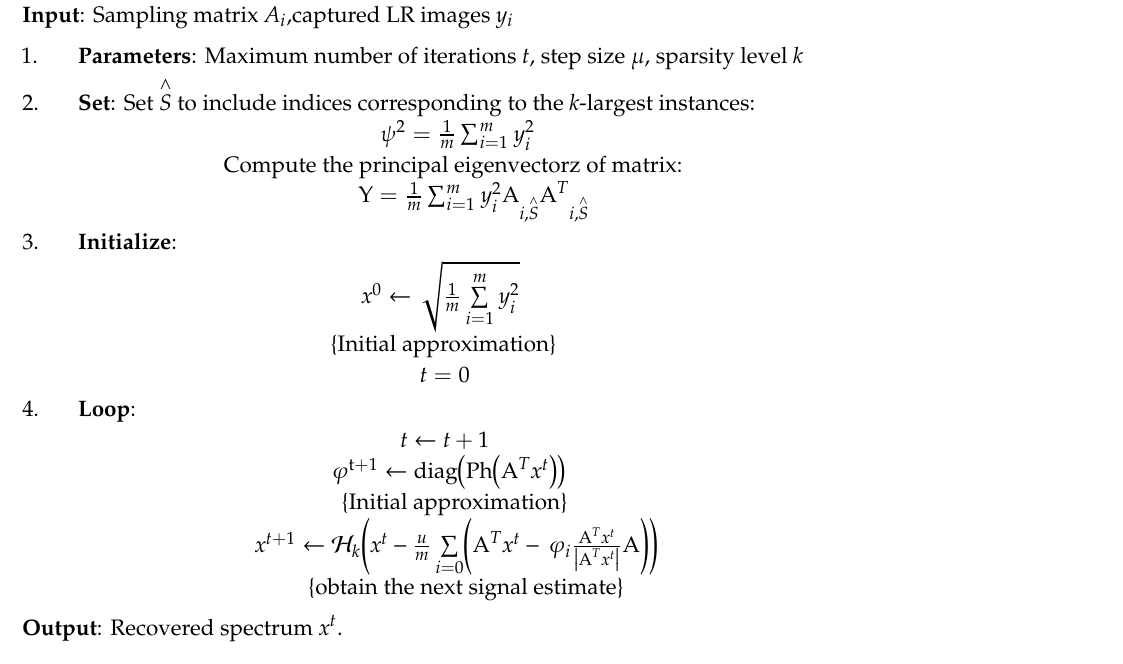
Algorithm 1 Long-distance sub-di ff raction high-resolution imaging for sparse